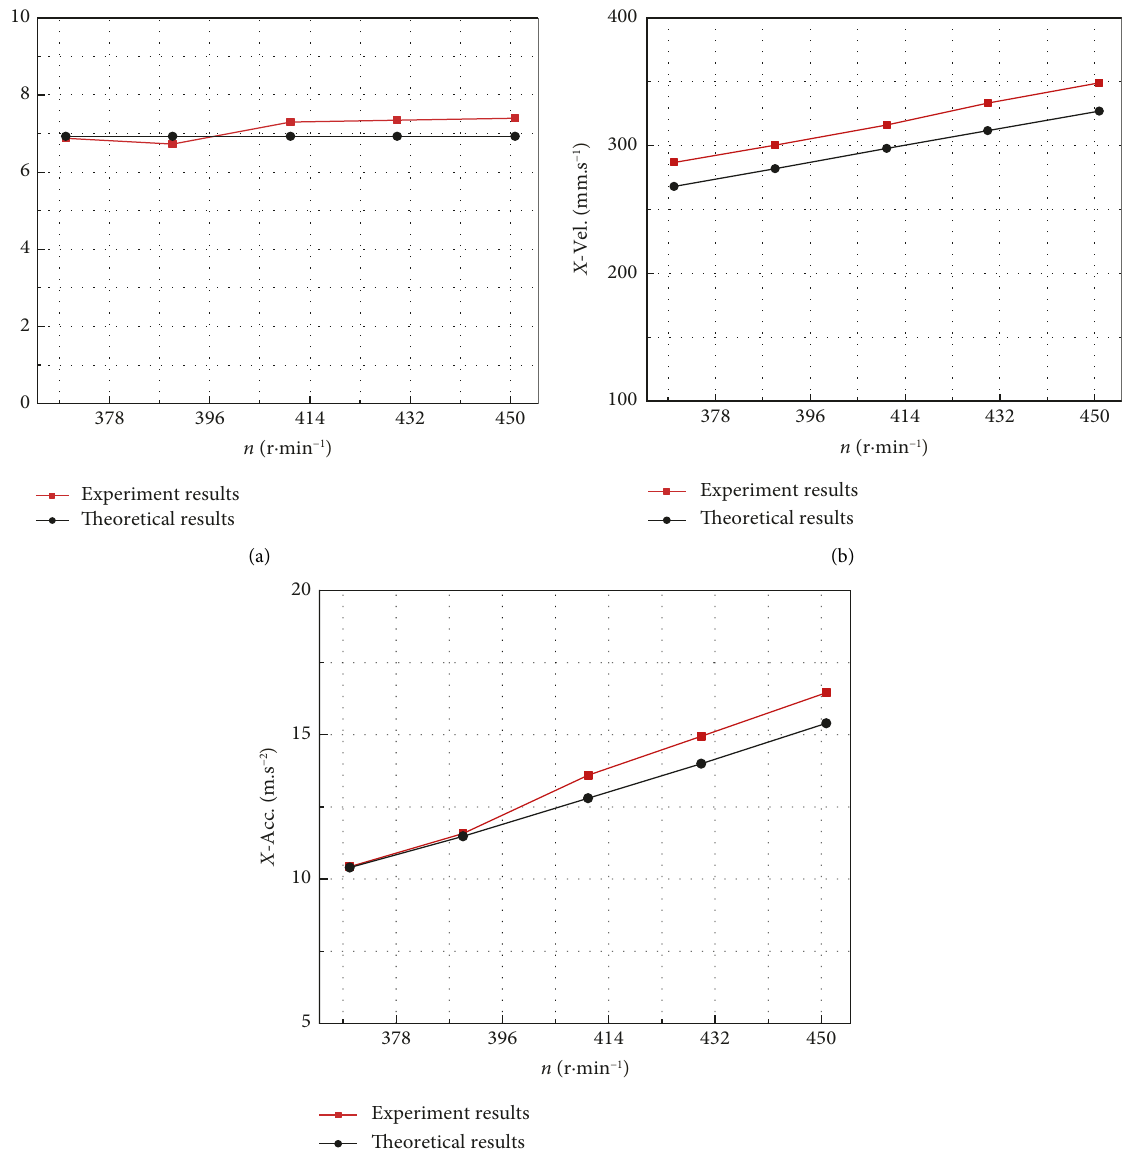
Figure 8: Dynamic characteristics along X -direction under different rotational speed between experiments and theoretical